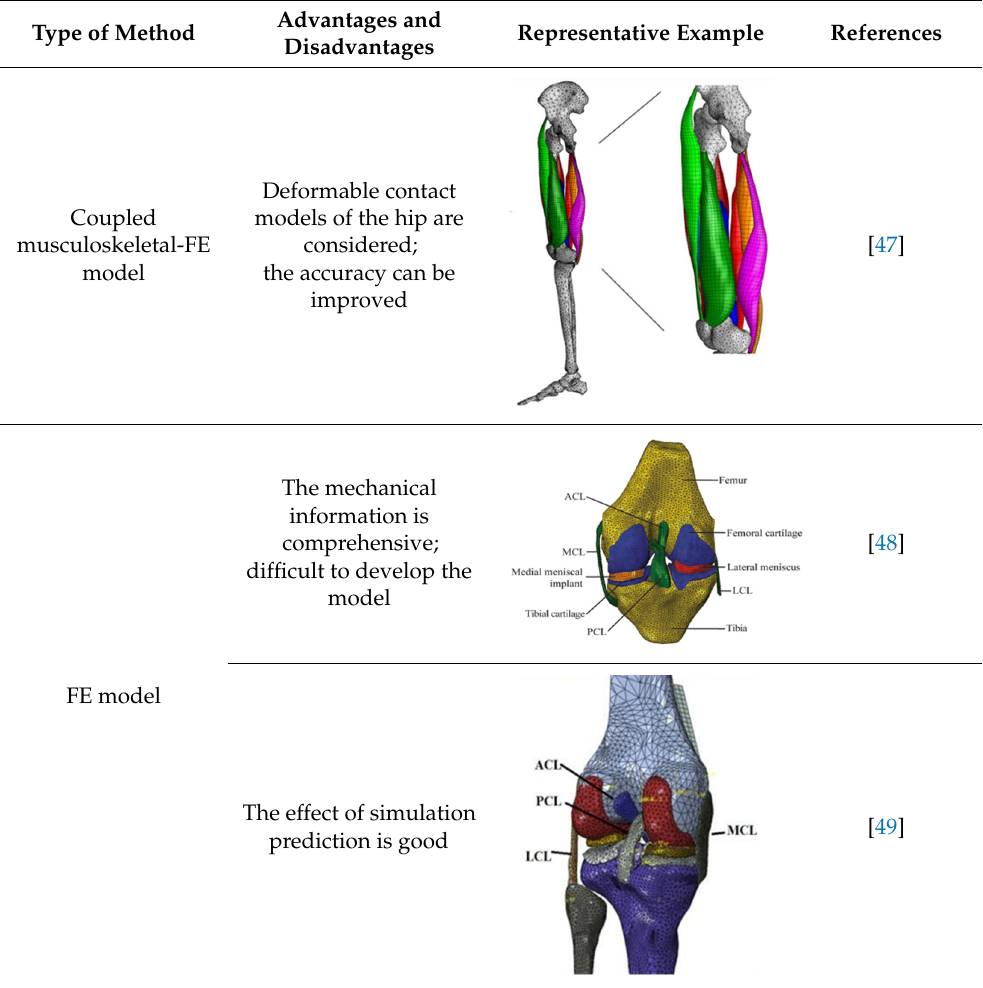
Table 7. The widely used in vitro testing methods for evaluating the performance of bone joint re- placements.